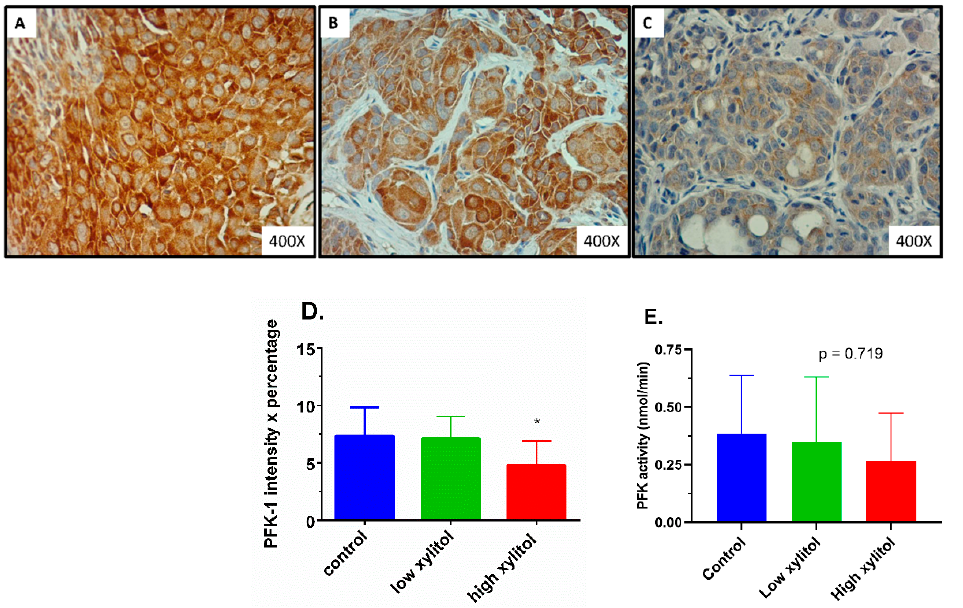
Figure 8. Expression and activity of PFK in tumor specimens of CAL-27 xenograft mice. PFK-1 expression of control ( A ), low-xylitol ( B ), and high-xylitol ( C ) groups. Bar graphs show the mean ± SEM of PFK-1 expression combined score ( D ) or PFK activities ( E ) of CAL-27 xenograft mice given the glucose solution ( (cid:4) control), low-xylitol solution ( (cid:4) ), and high-xylitol solution ( (cid:4) ). * represents p < 0.05 obtained from one-way ANOVA followed by Tukey’s multiple comparison